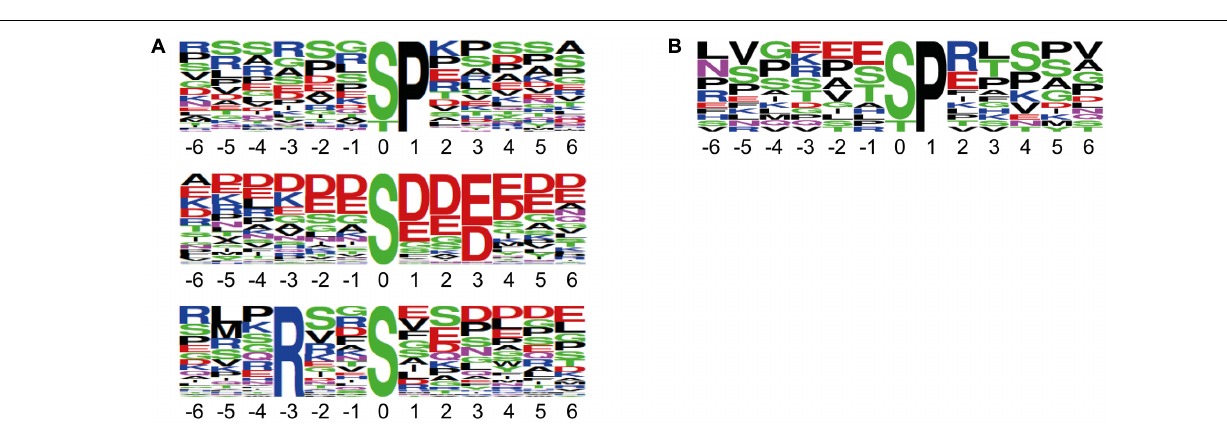
FIGURE 3 | Sequence motifs of phosphorylation sites identified by tandemMOAC. Sequence logos of the phosphorylation sites mapped to peptide amino acid sequences generated by Motif-X with a significance of 0.000001 and the IPI Arabidopsis proteome as background. (A) Phosphorylation motifs enriched from all phosphopeptides identified in the presented dataset. (B) The proline-directed phosphorylation motif overrepresented among the significantly regulated peptides induced upon in planta expression of